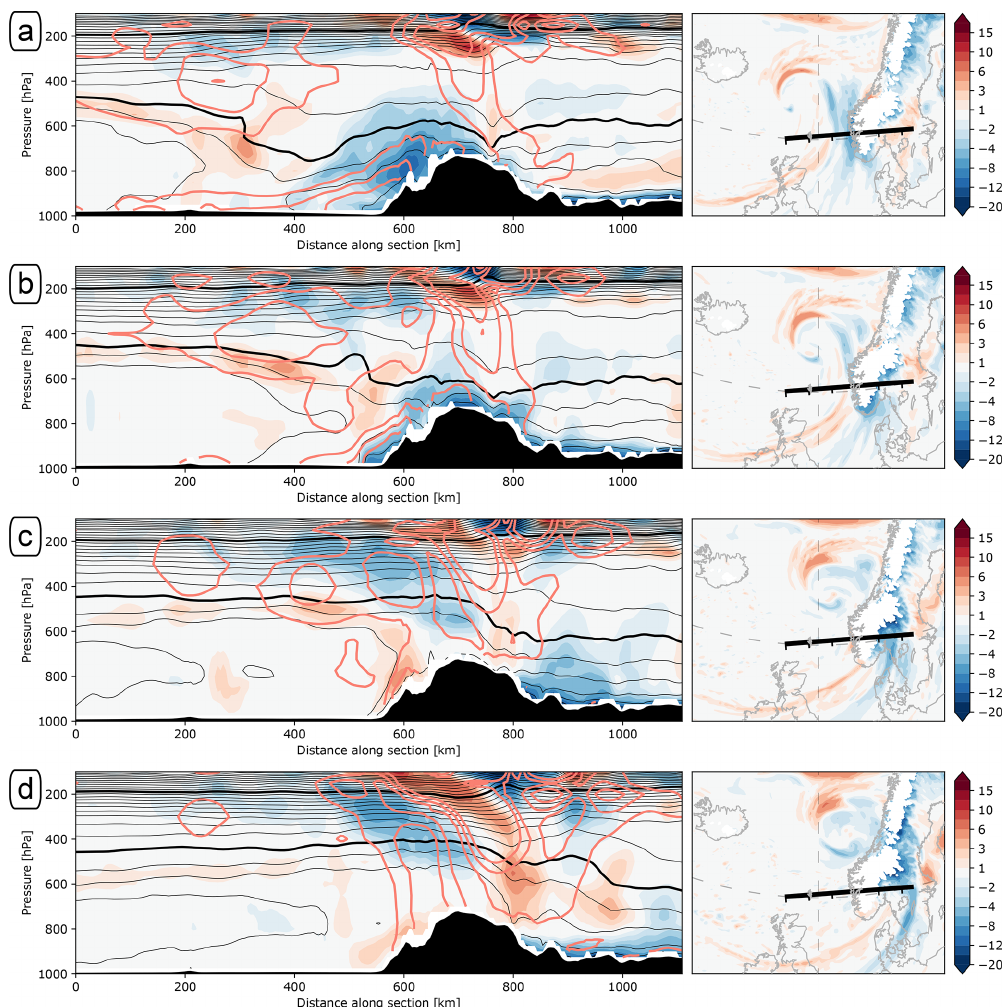
Figure 11. As Fig. 10, but showing in shading the equivalent potential temperature difference in kelvin between the Double and the Ocean simulations in both the section and the map. Contours show equivalent potential temperature and ageostrophic wind speed as in Fig. 10, but for the Double